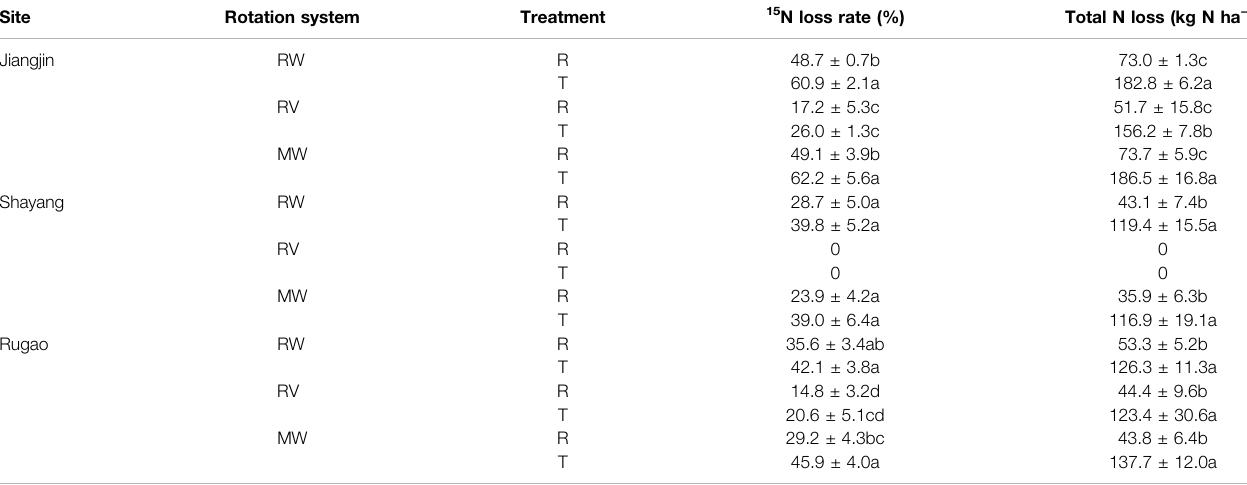
TABLE 4 | Average N losses as percentages and amounts from the crop rotations in the YRB (mean ± SD). Site